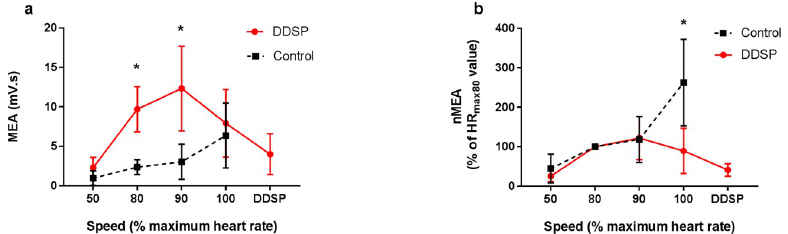
Fig 3. Mean electrical activity (MEA) of the thyro-hyoid muscle decreases at the highest exercise intensity in horses affected by palatal instability and intermittent dorsal displacement of the soft palate (DDSP). 3a) MEA showed significant difference between control and DDSP horses at lower exercise intensity. 3b) MEA normalized to the value recorded at HR max80 (nMEA), was significantly lower in horses diagnosed with DDSP compared to control at HR max100 . Data are expressed as mean with SD. � , p <